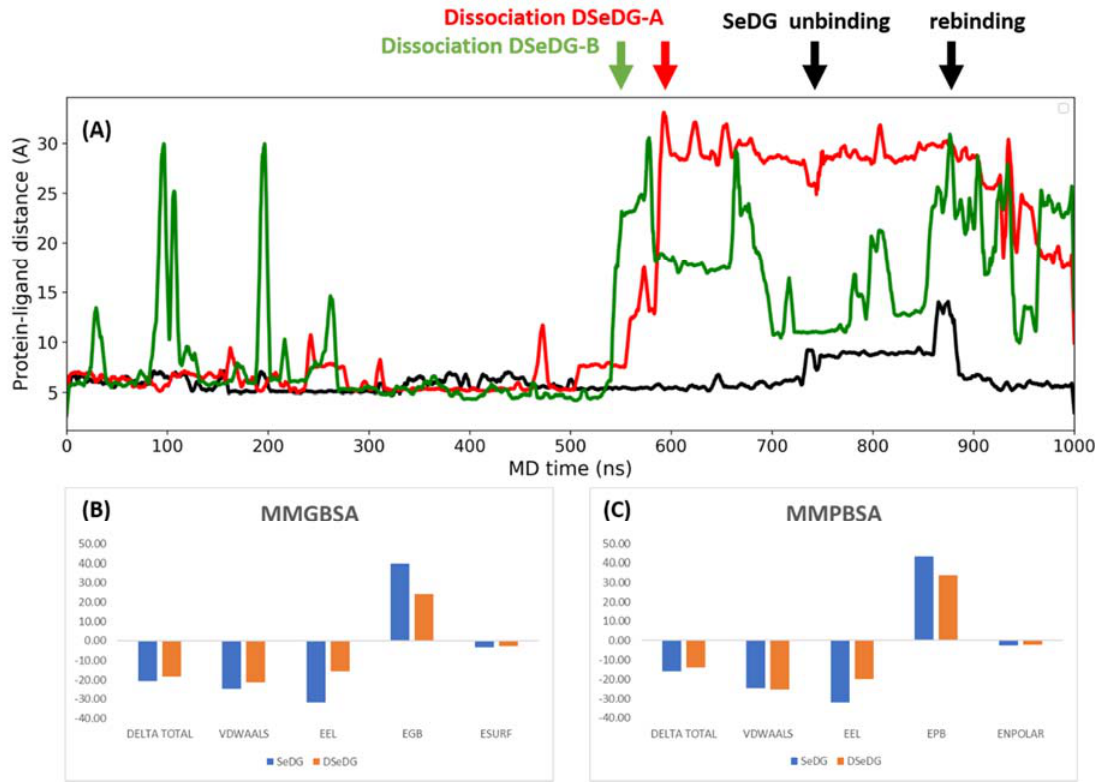
Figure 5. MD simulations started from the h Gal ‐ 3 CRD complexes. ( A ) Evolution of the distance between the subsite C and the ligand as measured by the distance between geometric centre of the Trp181 ring on the protein and the centre of the interglycosidic linkage of the ligands for SeDG (black), for DSeDG starting the simulation from binding mode A (red) and binding mode B (green). ( B , C ) The energetic contributions of the free energy of binding for SeDG in blue and DSeDG in orange to h Gal ‐ 3 CRD using the ( B ) MMGBSA and ( C ) MMPBSA calculations. The values only contain the binding enthalpy without the correction by entropic contributions to get the absolute values of free energies.